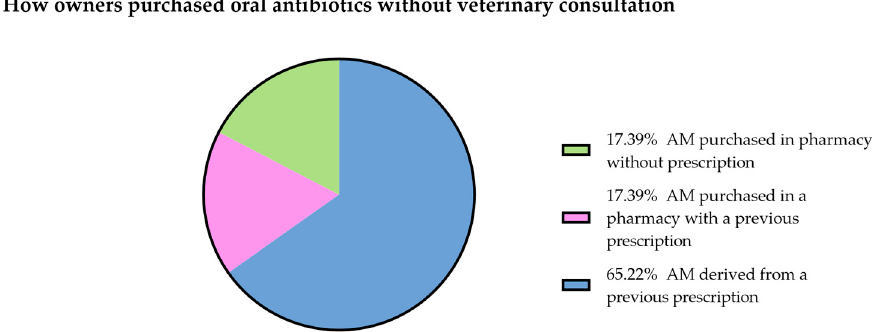
Figure 1. How owners purchased oral antibiotics without veterinary consultation.